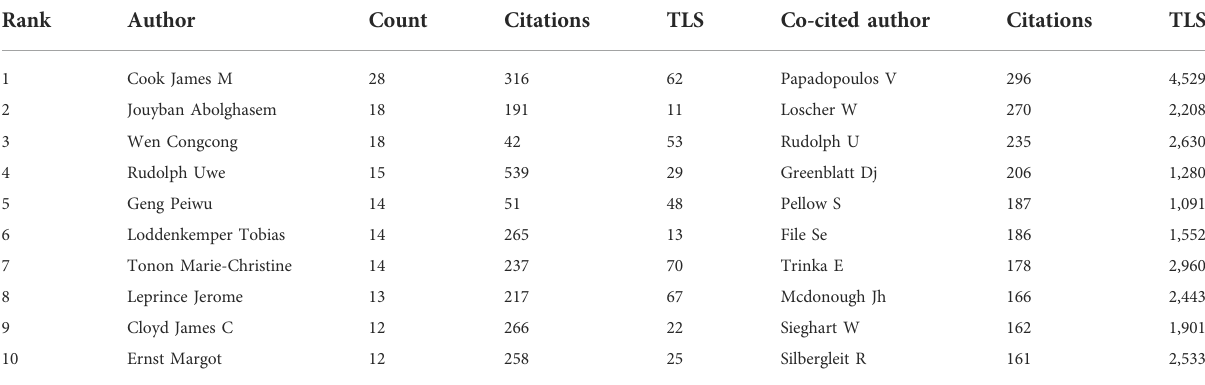
TABLE 2 Top 10 co-authors and co-cited authors in diazepam research.